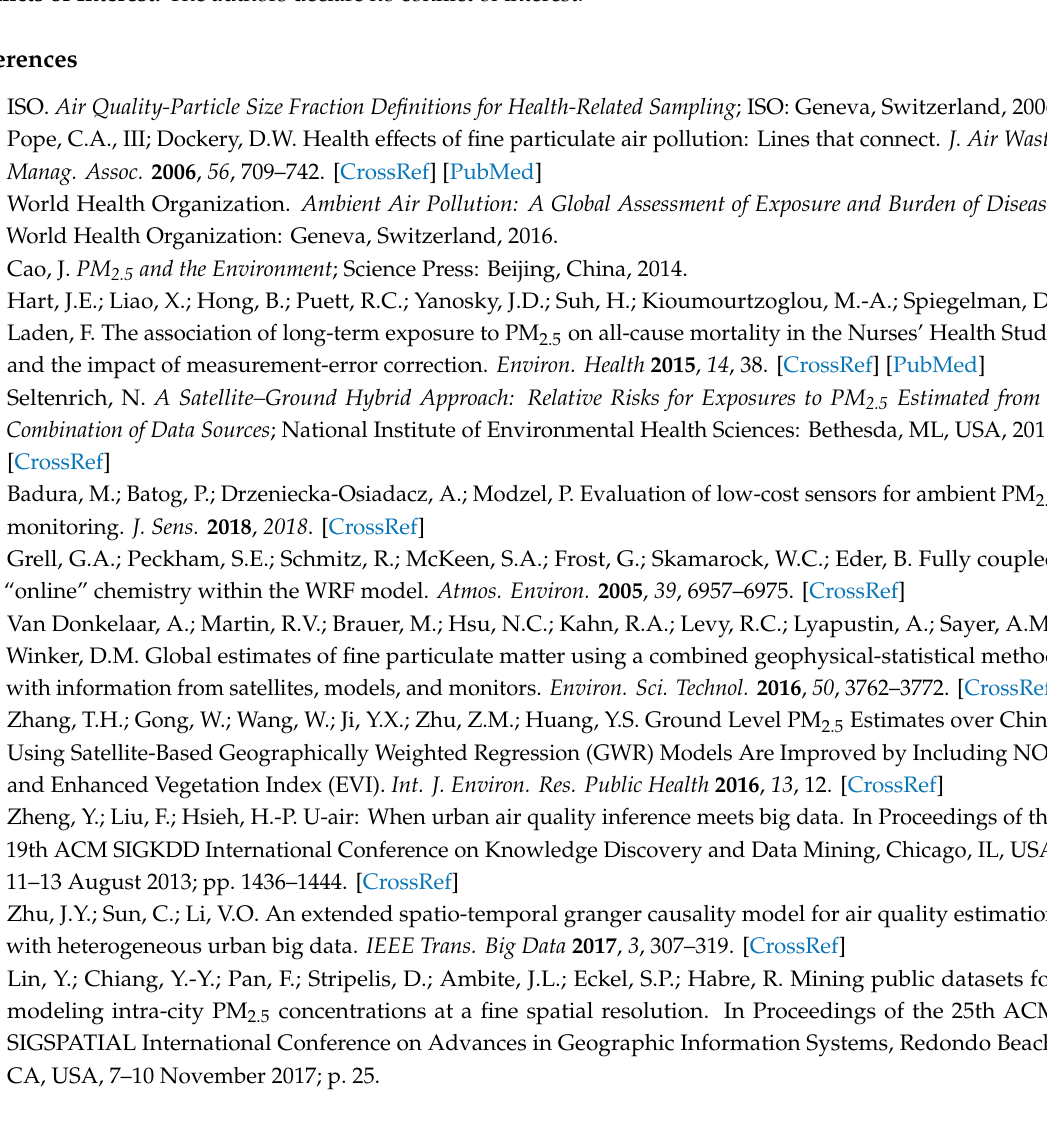
Table S1: Abbreviations for data sets and variables, Figure S1: Diagram of the composite analysis matrix based on Sample set A, Figure S2: Diagram of the composite analysis matrix based on Sample set